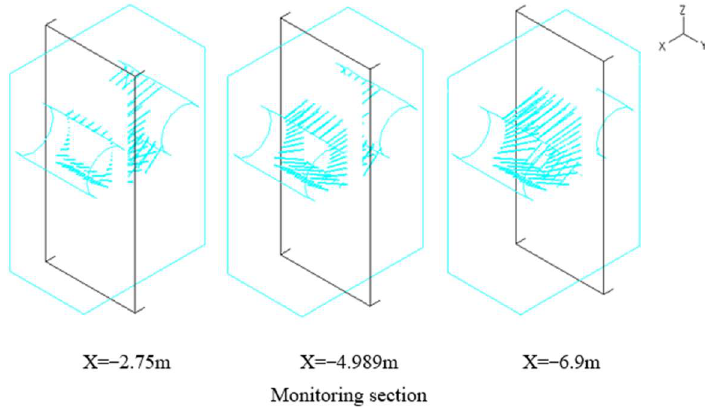
Figure 4. Schematic representation of the observation section.